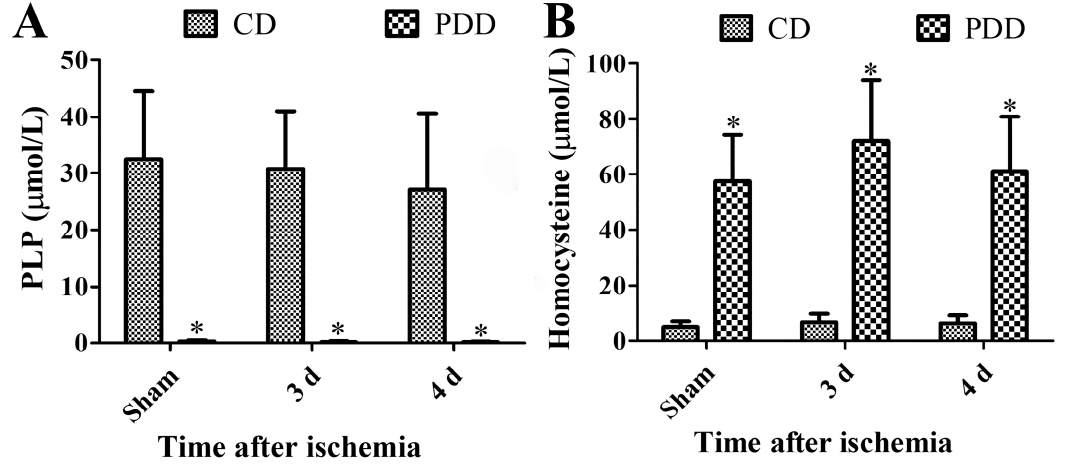
Figure 1. Pyridoxine deficiency decreases serum pyridoxal 5 ′ -phosphate (PLP) levels ( A ) and increases serum homocysteine levels ( B ) in the control diet (CD)- and pyridoxine-deficient diet (PDD)-fed gerbils of sham- and ischemia-operated groups. Data were analyzed with a two-way ANOVA test followed by Bonferroni post-hoc tests ( n = 7 per group; * p < 0.05, significant difference between CD- and PDD-fed group). All data are expressed as mean with standard deviation.